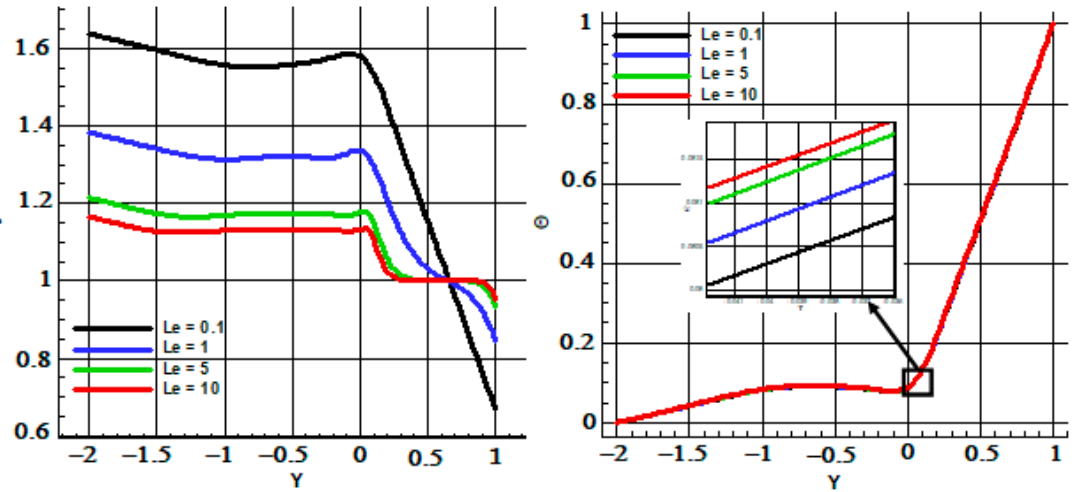
Figure 9. Concentration and temperature for different Le number and Pr = 6.2, Re = 100, N B = N T = 0.1.